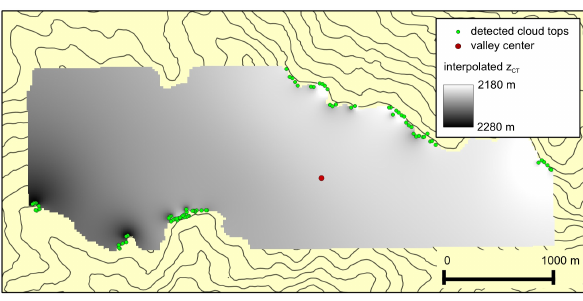
Figure 13. Cloud tops heights derived from the main cam footage taken on 15 March 2013 from 10:12 to 10:16UTC + 8. See Fig. 3 for